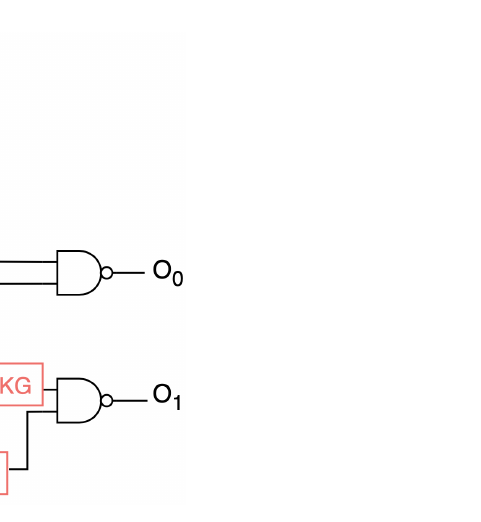
Figure 8. SKG-Lock+ insertion on a toy